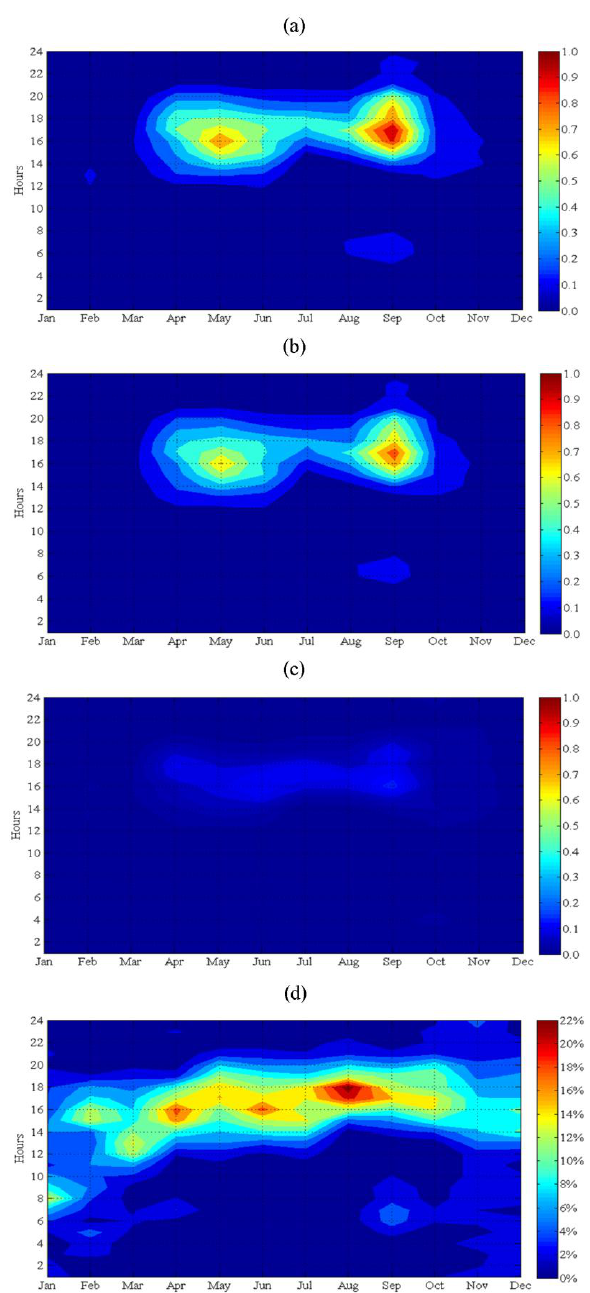
Figure 4. Month-hour distribution diagrams of the (a) normalized (unit maximum) total CGD; (b) normalized negative CGD; (c) nor- malized positive CGD; (d) hourly relative contribution to total CGD in each month (in percent) recorded over Portugal in 2003–2009.